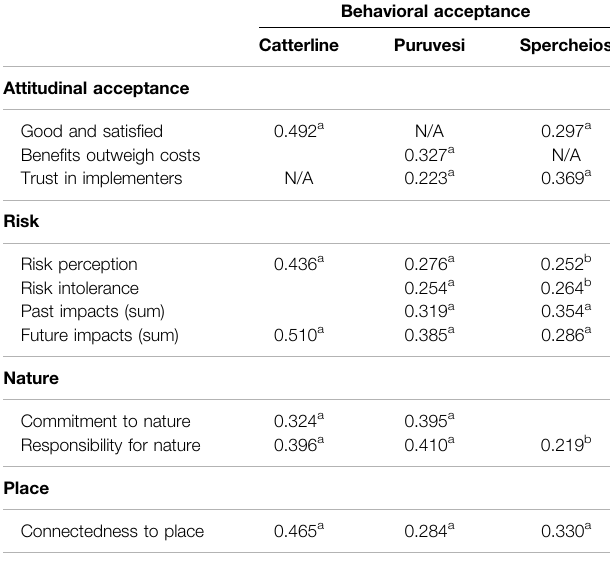
TABLE 5 | Spearman ’ s rho ( ρ ) correlation coef fi cients of attitudinal acceptance factors and risk, nature, and place survey variables with behavioral acceptance inthethreestudysites.Onlycorrelationssigni fi canttoatleast p < 0.10 are shown here. N/A (not applicable) is used when the factor did not de fi ne attitudinal acceptance in that